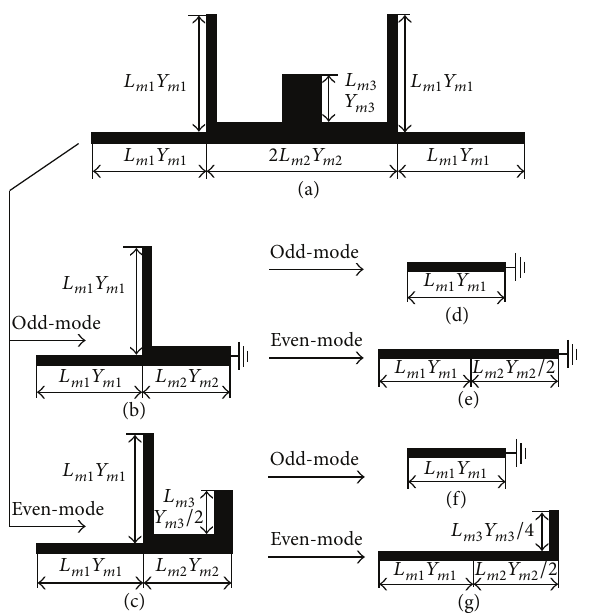
Figure 1: (a) The proposed stub-loaded trimode resonator; (b) odd-mode circuit of (a); (c) even-mode circuit of (a); (d) odd-mode circuit of (b); (e) even-mode circuit of (b); (f) odd-mode circuit of (c); (g) even-mode circuit of (c).